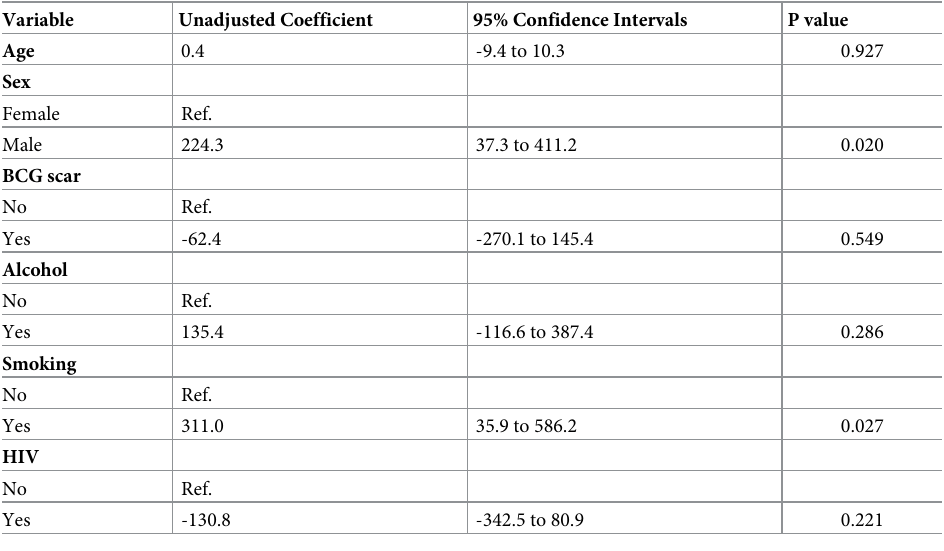
Smaller values made as references p value < 0.05